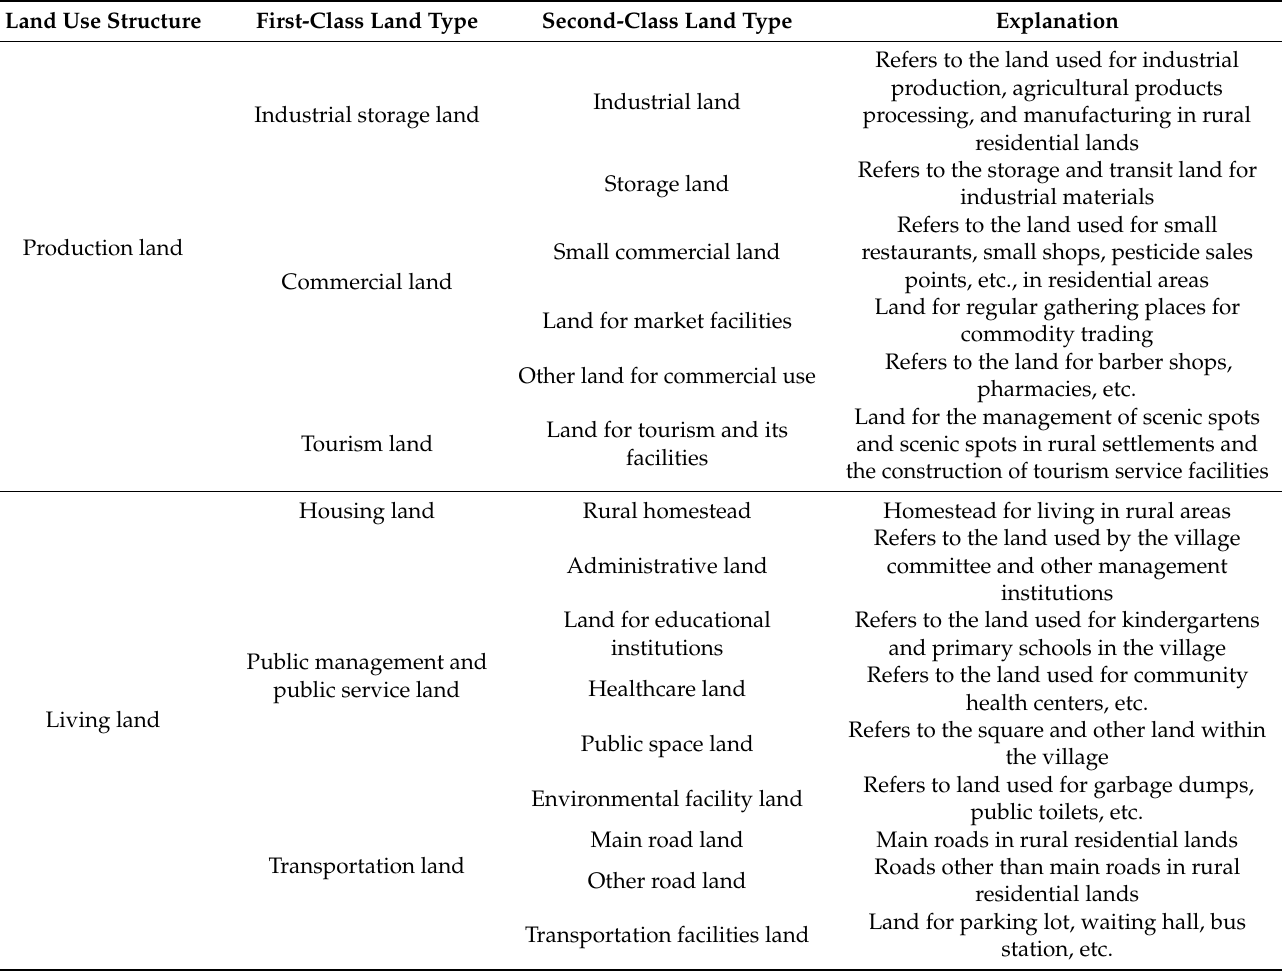
Table 2. Classification system of land use in rural